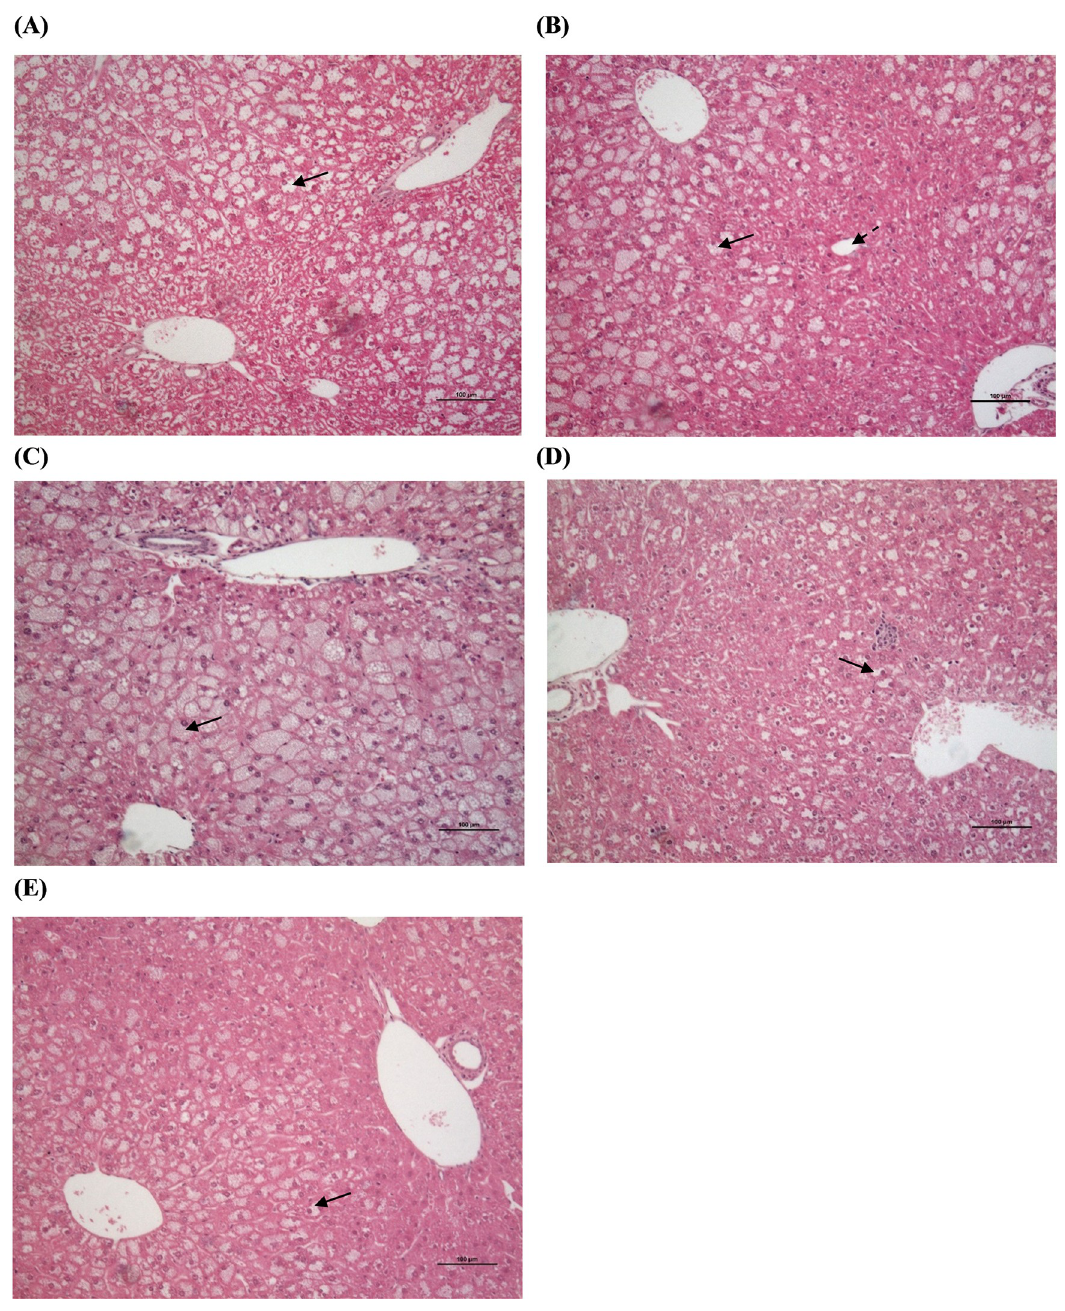
Fig 3. Histological assessment of H&E stained liver sections from 11-week old obese db/db mice treated with (a) db/db control, (b) GRT (100 mg/kg BW), (c) Pio (25 mg/kg BW), (d) Ator (80 mg/kg BW), and (e) GRT with Pio and Ator combination for 5 weeks. Untreated obese db/db control (a) mice presented with mediovesicular type steatosis across all acinar zonal areas. GRT treated obese db/db (b) mice presented with a mixed steatotic appearance of micro- and mediovesicular lipid accumulation predominantly in the central lobular areas. Pio treatment (c) presented with microvesicular type steatosis across acinar zonal areas. Ator treated (d) mice presented with mixed micro- and mediovesicular steatosis type present mostly in the centrilobular area. The combination of GRT, Pio and Ator (e) presented with a microvesicular type of steatosis limited to the centrilobular areas. Microvesicular steatosis represented by a bold arrow and mediovesicluar steatosis by a dotted line arrow. Magnification x 200; scale bar 100 μ m. GRT, green rooibos extract; Pio, pioglitazone; and Ator, atorvastatin.